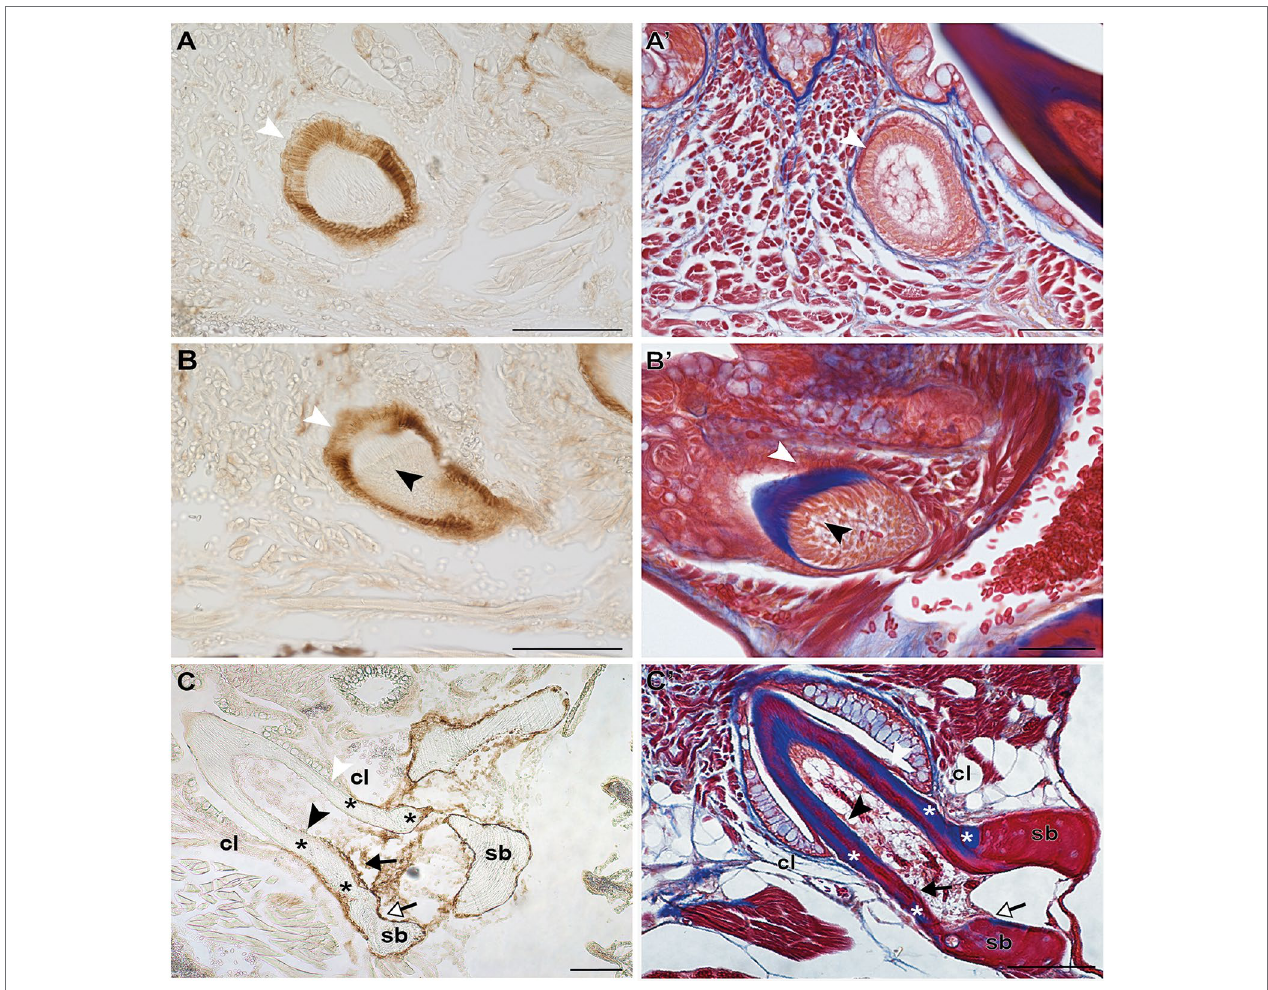
FIGURE 3 | Zns-5 immunodetection during adult zebrafish tooth development. Transverse sections of adult zebrafish in the region of the pharyngeal jaws, used for Zns-5 immunohistochemistry (A–C) or stained with azan (A’–C’) . During EC (A,A’) and LC (B,B’) , Zns-5 is localized in ameloblasts, with no signal detected in odontoblasts. When teeth are attached (C,C’) ameloblasts cease to stain for Zns-5 and the antigen is only detected in the cells lining the “bone of attachment” and the osteoblasts lining the supporting bone. Note osteocytes in the supporting bone, but their absence in the “bone of attachment” (C’) . cl, cervical loop; sb, supporting bone; asterisks, “bone of attachment”; black arrowheads, odontoblasts; black arrows, cells forming “bone of attachment”; white arrowheads, ameloblasts; white arrows, osteoblasts. Scale bar (A–D, C,’D’) = 100 μ m, (A’,B’) = 50 μ